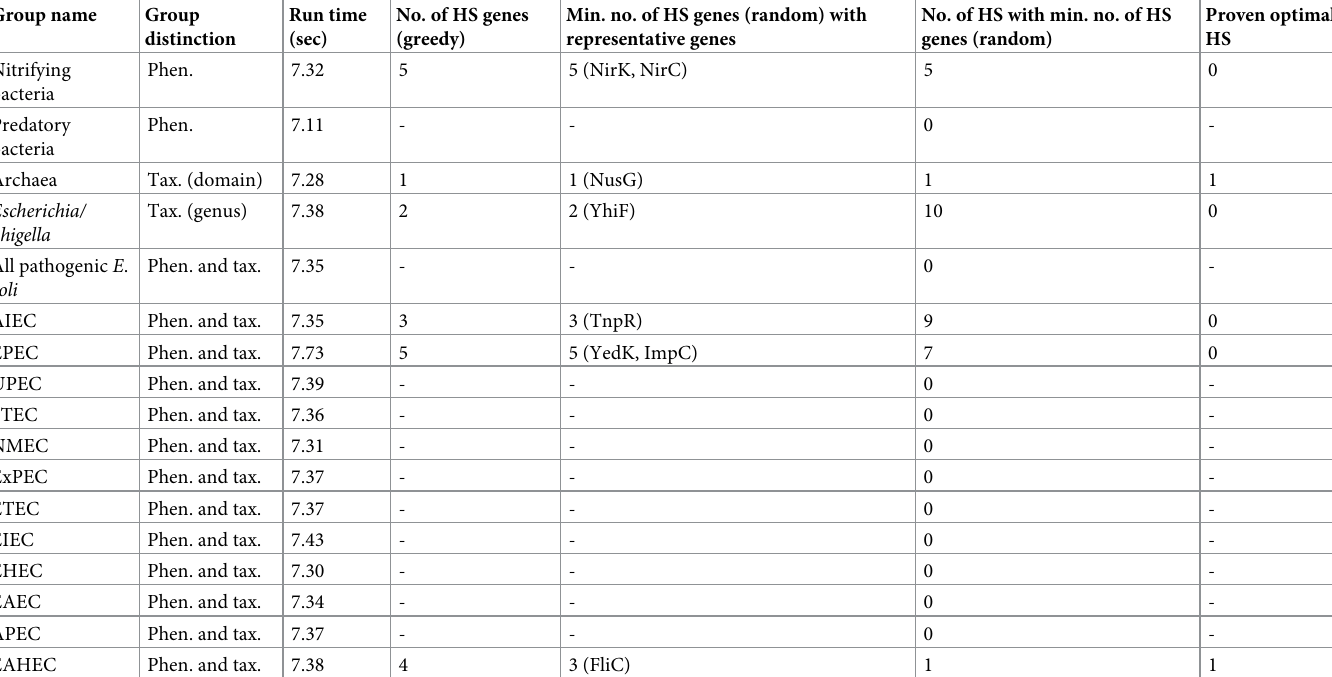
Table 1. Hitting sets (marker proteins) of 17 microorganism groups. HS, hitting set. Min., minimal. Greedy and random refer to the algorithm type. Phen., phenotypic. Tax., taxonomic. AIEC, adherent-invasive E . coli . EPEC, enteropathogenic E . coli . UPEC, uropathogenic E . coli . STEC, Shiga toxin-producing E . coli . NMEC, neonatal meningitis-associated E . coli . ExPEC, extra-intestinal pathogenic E . coli . ETEC, enterotoxigenic E . coli . EIEC, enteroinvasive E . coli . EHEC, enterohemorrhagic E . coli . EAEC, enteroaggregative E . coli . APEC, avian pathogenic E . coli . EAHEC, enteroaggregative hemorrhagic E . coli